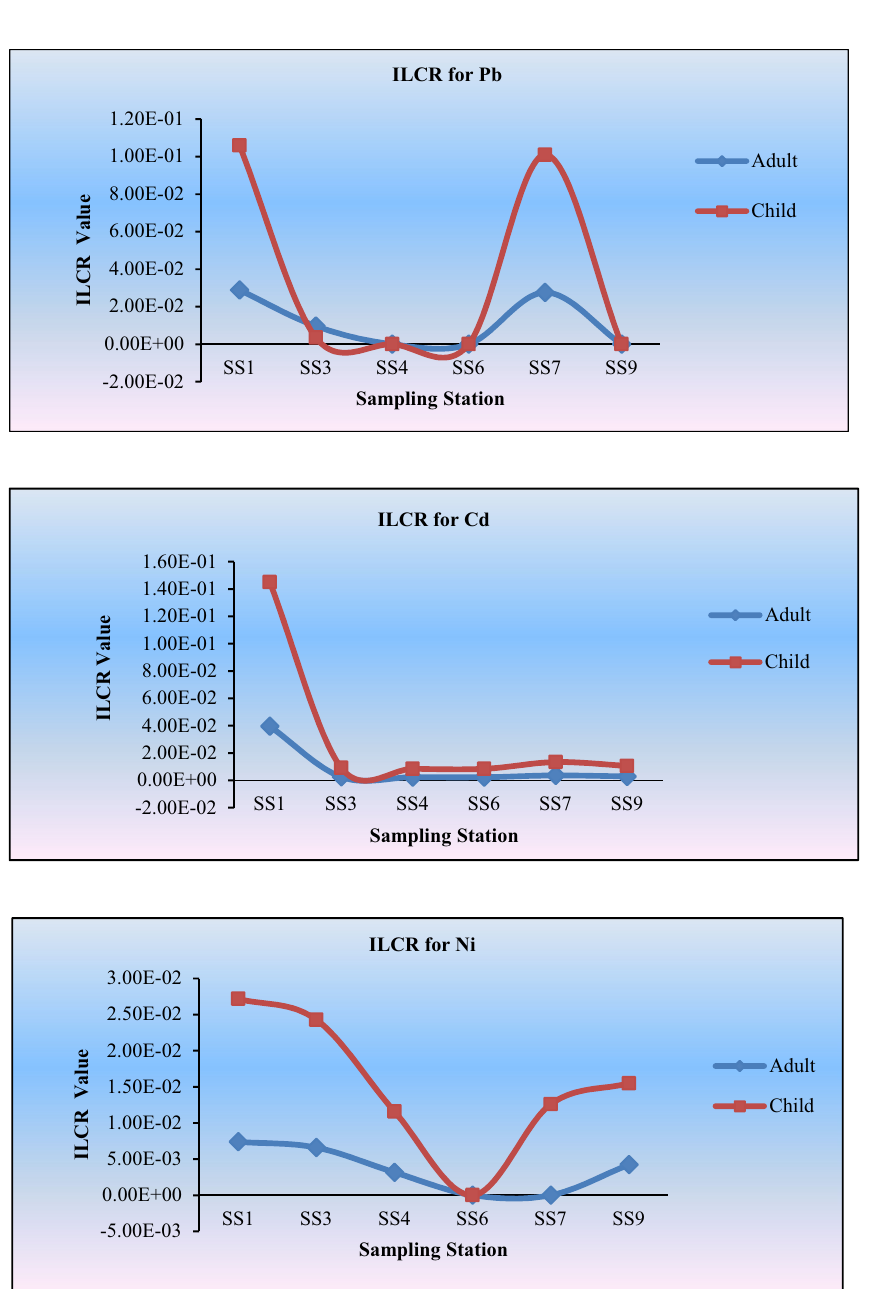
Figure 7. The incremental lifetime cancer risk (ILCR) for TMs in the blowout